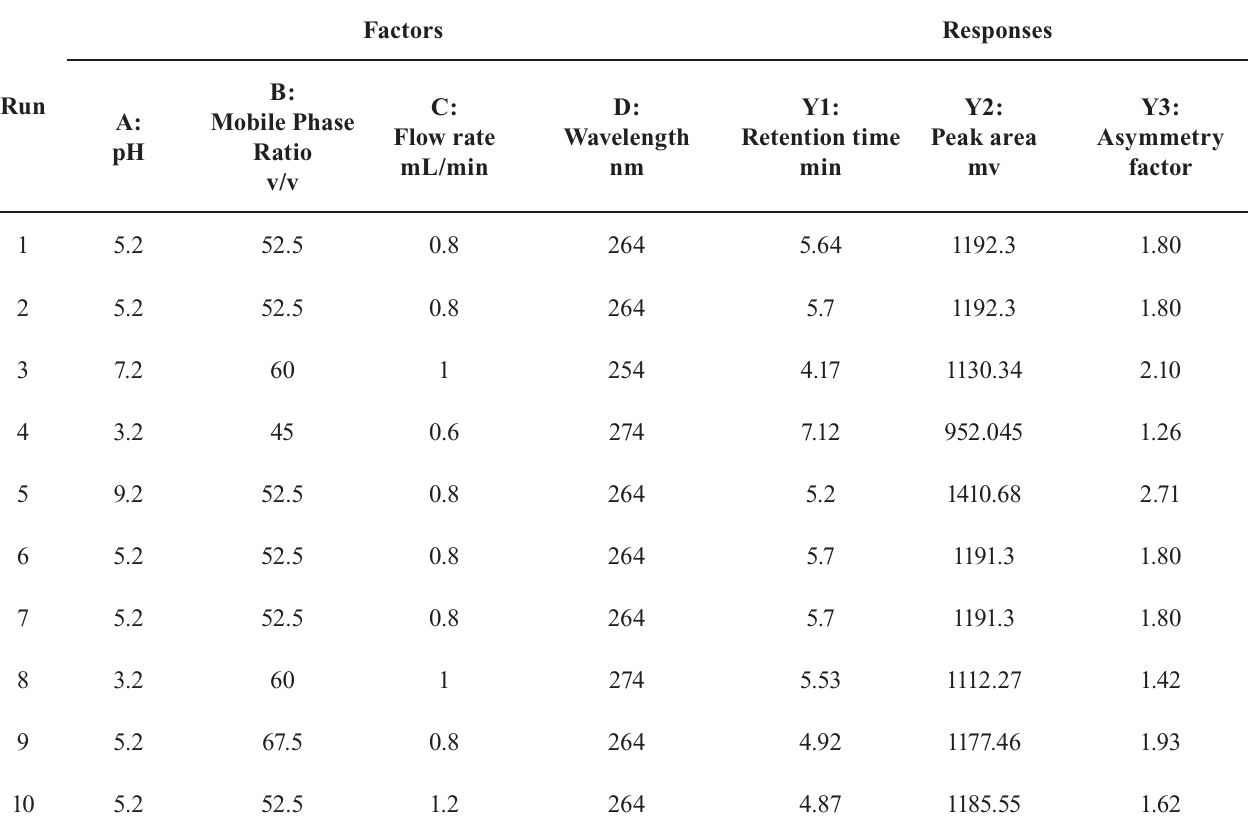
TABLE II - Optimization method parameters for central composite design